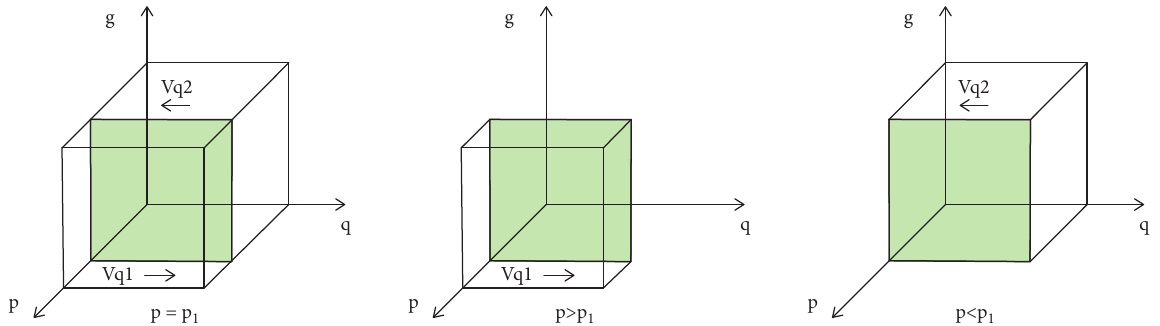
Figure 3: Phase diagram of mediation platform strategy